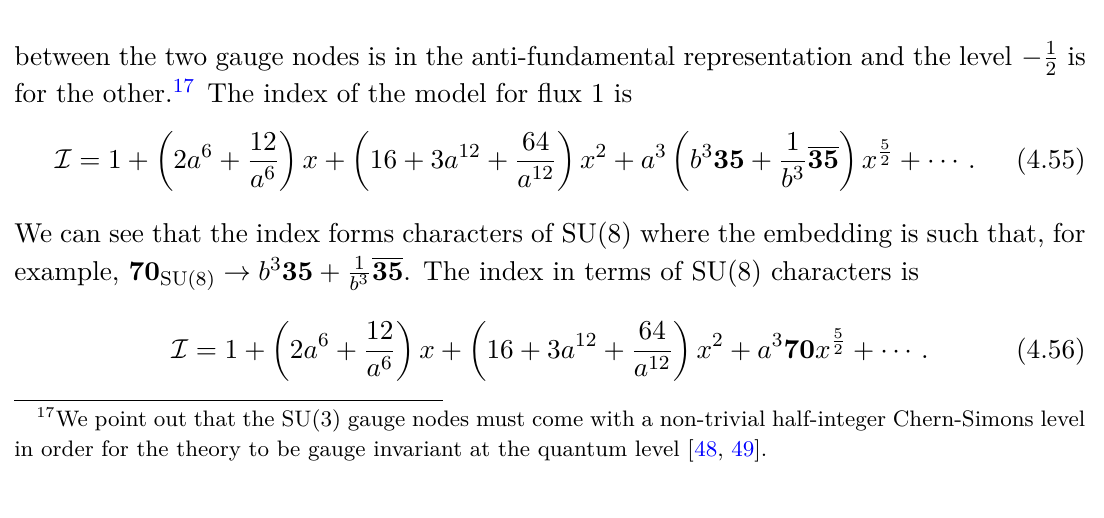
Figure 9 . Flow pattern triggered by mass deformations for the N = 2 case. At each step we specify the 5 d SCFT ( 6 d SCFT for the first step), the 5 d gauge theory based on SU group that is UV completed by it and the split of the associated 3 d N = 2 theory that is obtained from the torus compactifications. For some SCFTs we can have more splits and each one is associated with a different factor inside the 5 d global symmetry for which we turn on the